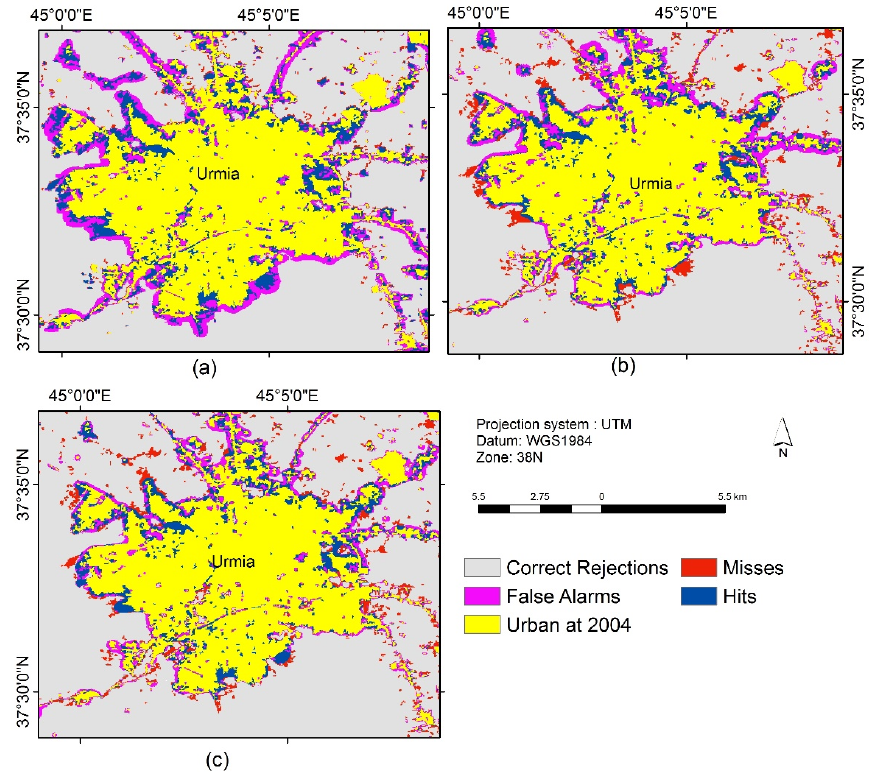
Figure 7. Correctness and errors of the results from simulation models for 2014. ( a ) CA-logistic model, ( b ) PSO-CA model, and ( c ) ABC-CA model.